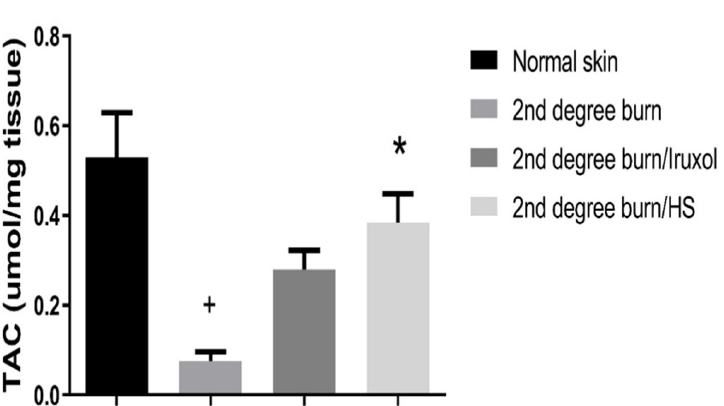
Figure 5. Effect of HS on total antioxidant capacity (TAC). TAC: Total antioxidant capacity; HS: Hibiscus sabdariffa; +, ( p < 0.05) vs. normal group; *, ( p < 0.05) vs. 2nd degree burn group. Differences between groups were examined by ANOVA/Tukey-Kramer’s multiple comparison test. n = 6.